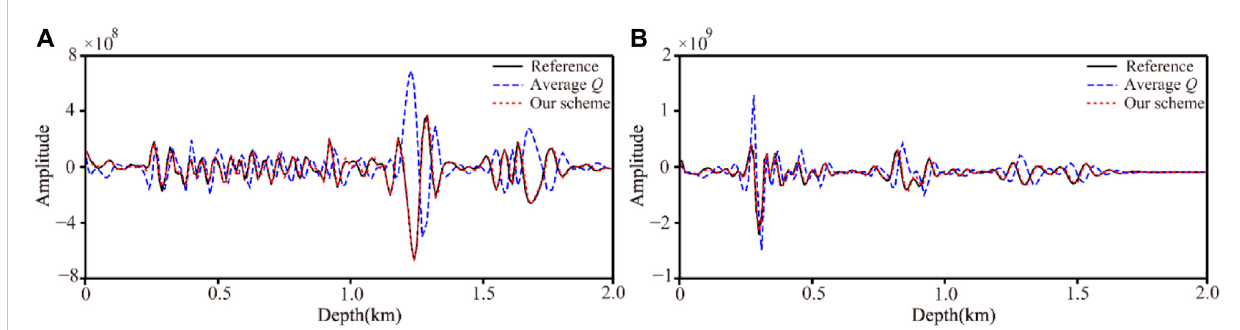
FIGURE 9 Vertical pro fi les of different migration images. (A) at x = 1.5 km; (B) at x = 3.5 km.